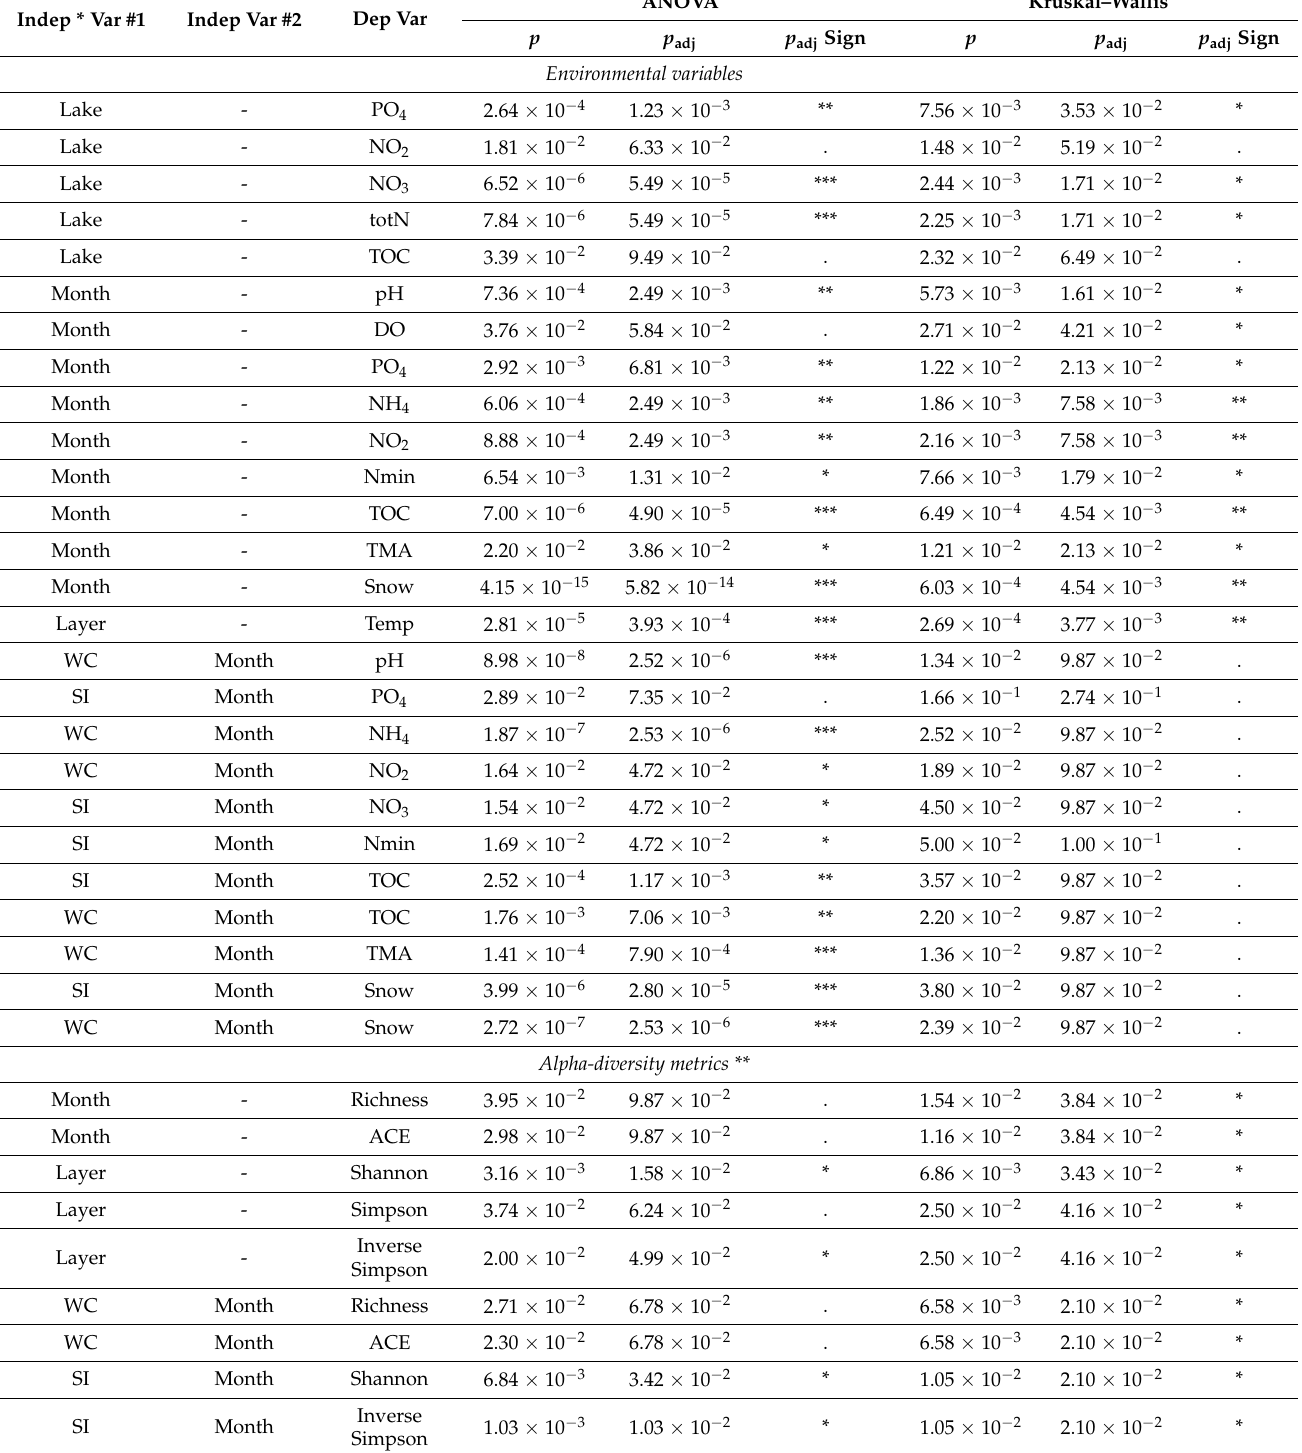
Column legend: Indep Var #1/2—independent variables used to divide the dataset into subgroups; Dep Var—tested dependent variable; ANOVA/Kruskal–Wallis p -values; p — p -value; p adj —FDR-adjusted p -value; adj ≤ 0.1 are shown, i.e., cases where the factor-wise distributions of dependent variable differ significantly; **—May and June groups were merged when the alpha-diversity metrics were